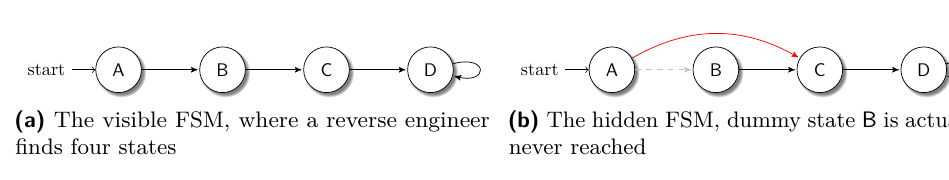
Figure 1: A simple Doppelganger FSM Table 1: Exemplary encodings of the states for our FSM State A